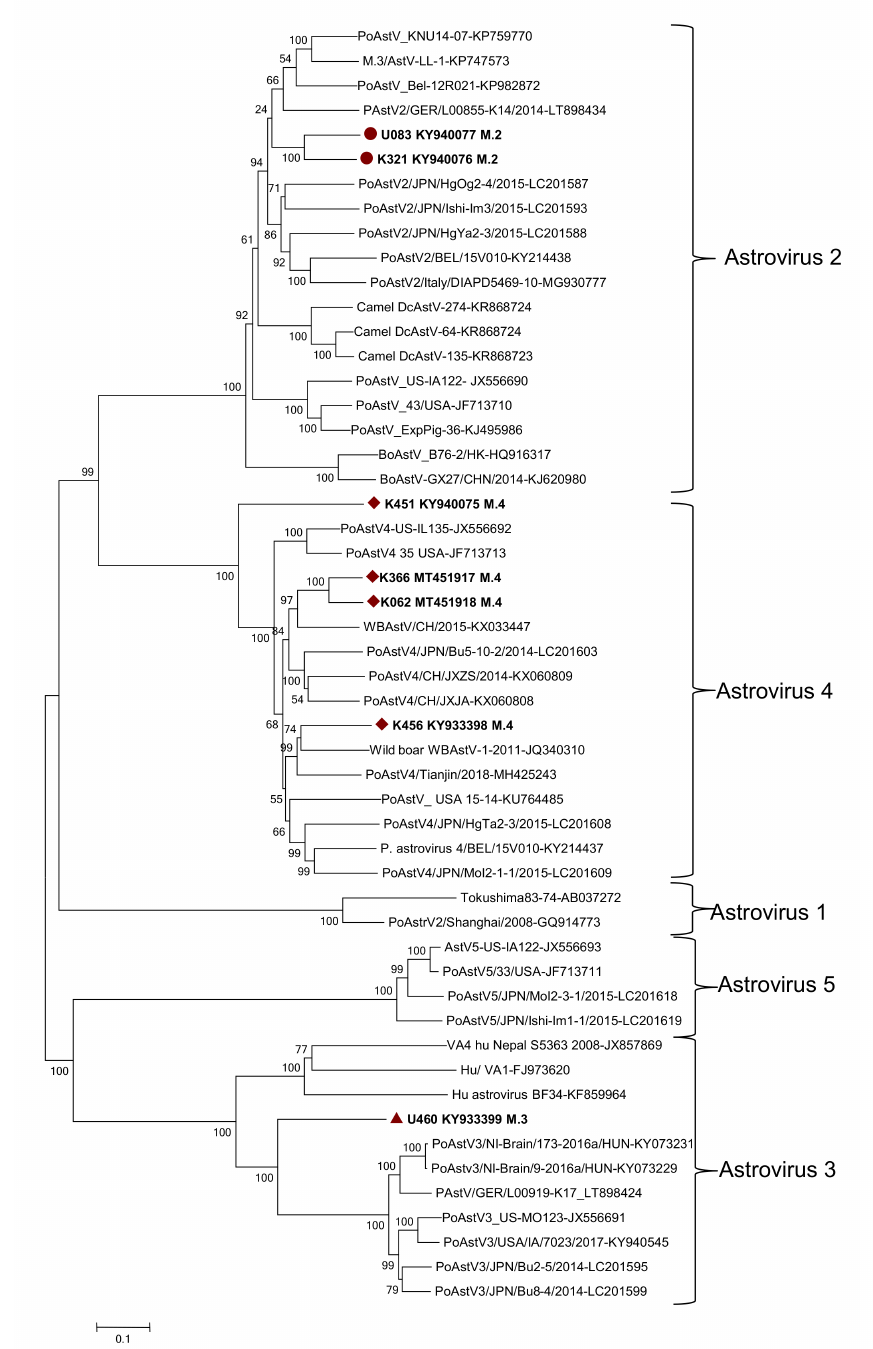
Figure 1. Phylogenetic analysis based on the complete (nearly complete, U460) nucleotide sequences of the full-length genome of East African PoAstVs ( bold ) and representative AstVs of humans and other species in the GenBank. Multiple sequence alignments were performed using the ClustalO program. The evolutionary history was inferred by using the maximum likelihood method based on the general time reversible model in MEGA X [33]. The scale bar is given in numbers of substitutions per site. Phylogeny was inferred following 1000 bootstrap replications, and the node values show percentage bootstrap